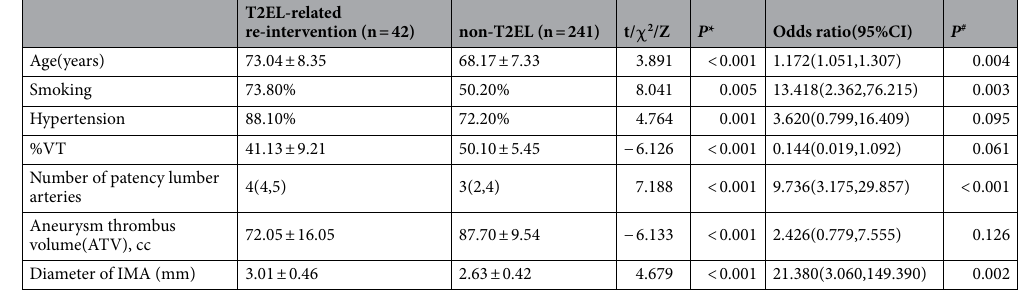
Table 3. Multivariate analysis on the risk factors that may lead to T2EL re-intervention. P *, t/ χ 2 /Z; odds ratio and P # , logistic regression analysis.